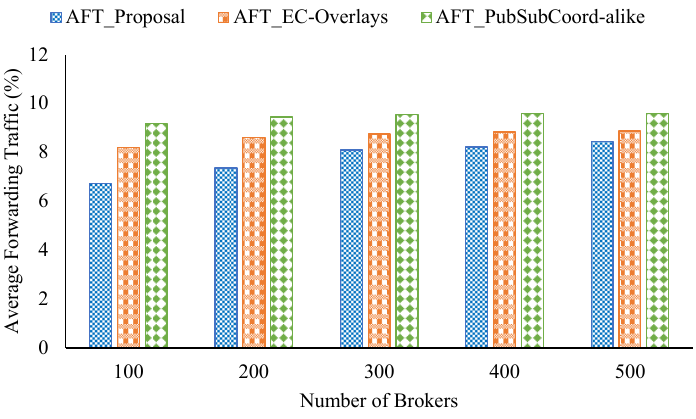
Figure 11. Relay traffic from varying the number of